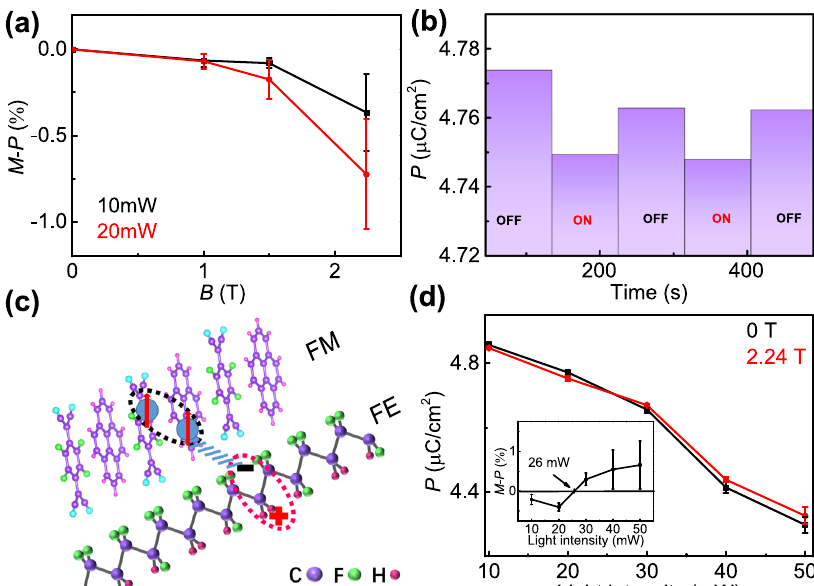
Fig. 3 Magnetoelectric coupling with different light intensities. a Magnetic fi eld dependence of electric polarization of multiferroic P-F4TCNQ/P(VDF-TrFE) complexes under light illuminations of 10 mW and 20 mW. b The ON (OFF) in the inset means that magnetic fi eld is tuned on (off). Magnetic fi eld is 2.2 T. c The diagram of dipole – dipole interaction in multiferroic P-F4TCNQ/P(VDF-TrFE) complexes. d Light intensity dependence of electric polarization of multiferroic P-F4TCNQ/P(VDF-TrFE) complexes with and without external magnetic fi eld stimulus. The inset is light intensity dependence on M – P. The error bars are standard deviations of three times. ON/OFF cycles measurements with different magnetic fi